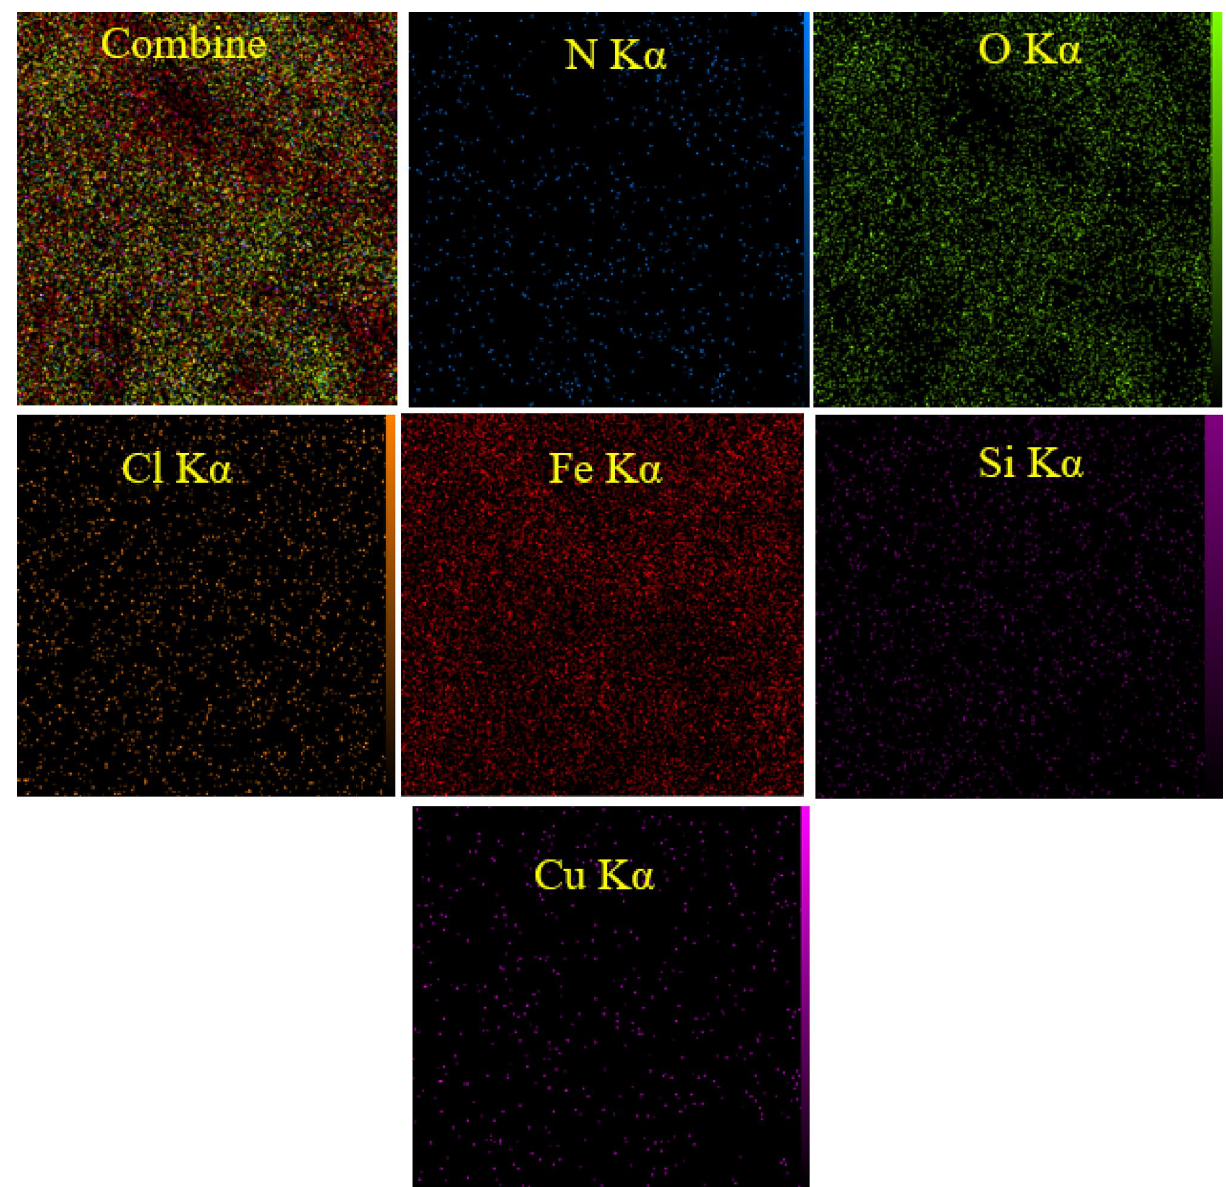
Figure 9. Elemental mapping images of FNAOSiPAMP/Cu II